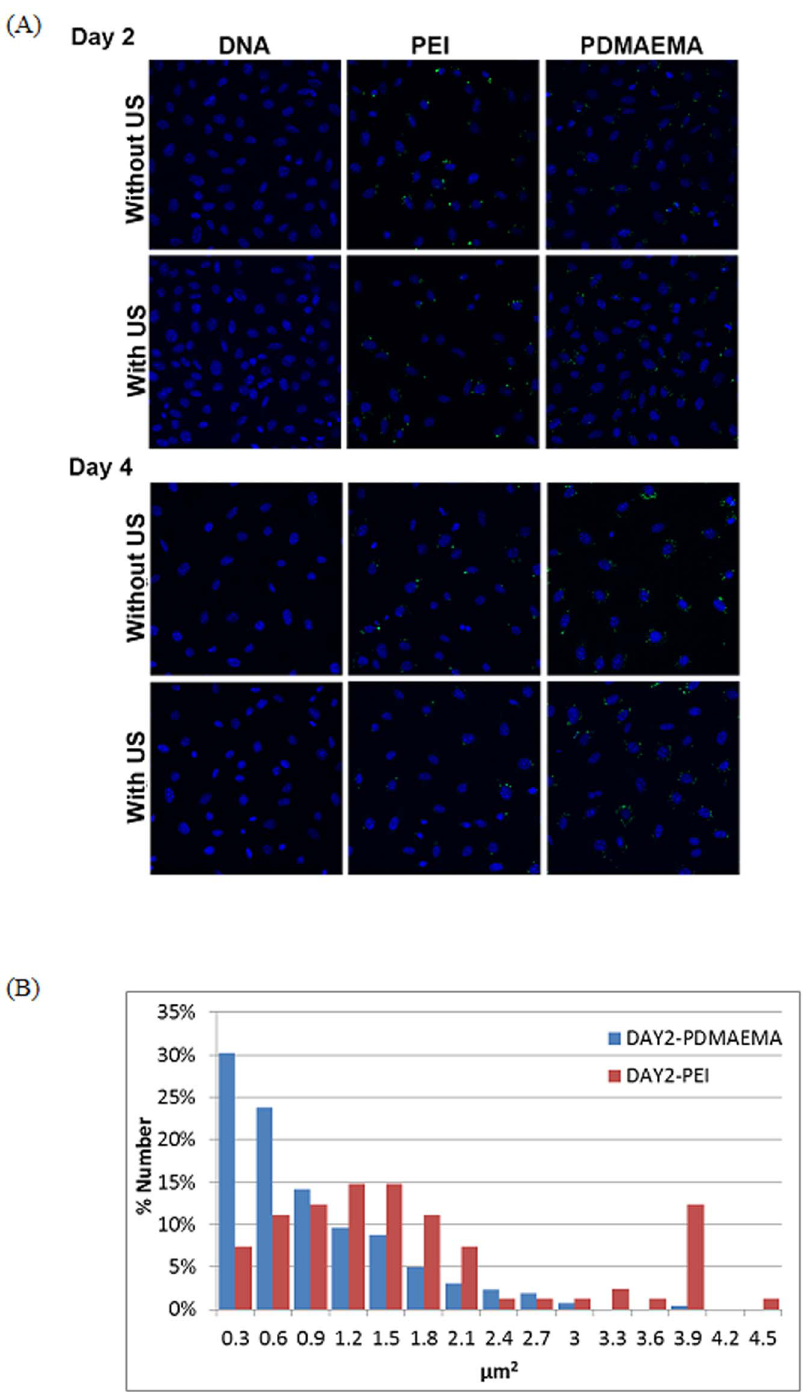
Figure 6. Confocal images of fluorescence labeled DNA for BNL cells treated with DNA, DNA/PEI and DNA/PDMAEMA with or without US exposure. Green: Fluorescein labeled DNA and Blue: DAPI-stained nucleus. (A) The cells were transfected for 24 h and further incubated for 2 days and 4 days. (B) Quantification of the size distribution of transfected PEI/DNA and PDMAEMA/DNA nanoparticles.